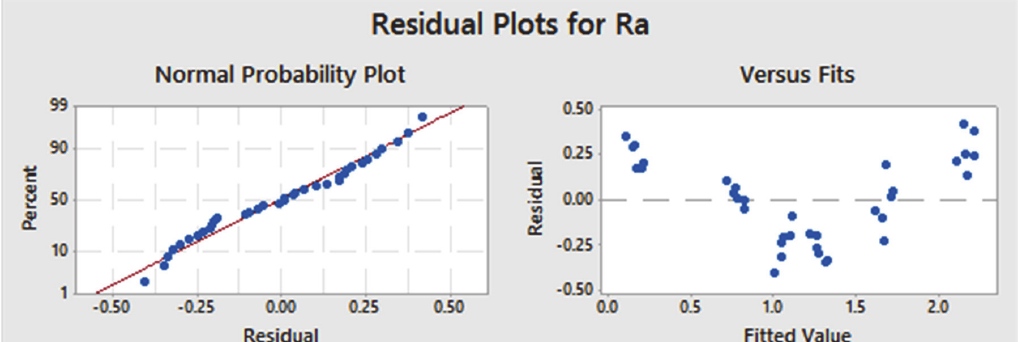
Fig. 9. Normal probability plot of residual and Plot of residual vs. fitted surface roughness values